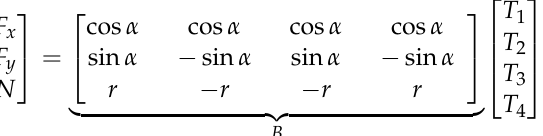
of freedom; ( b ) thrust distribution diagram of UUV. freedom; ( b ) thrust distribution diagram of